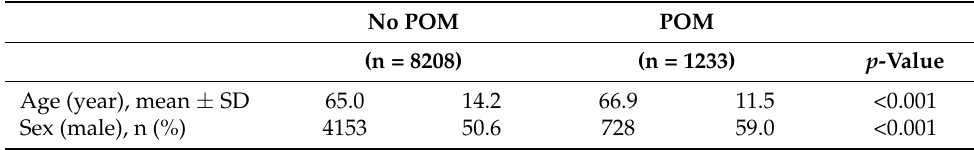
Table 1. Characteristics of the No POM and POM groups. No POM POM (n = 8208) (n = 1233) p -Value 65.0